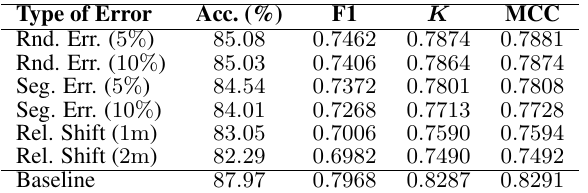
Table 3. Evaluation metrics for Potsdam test